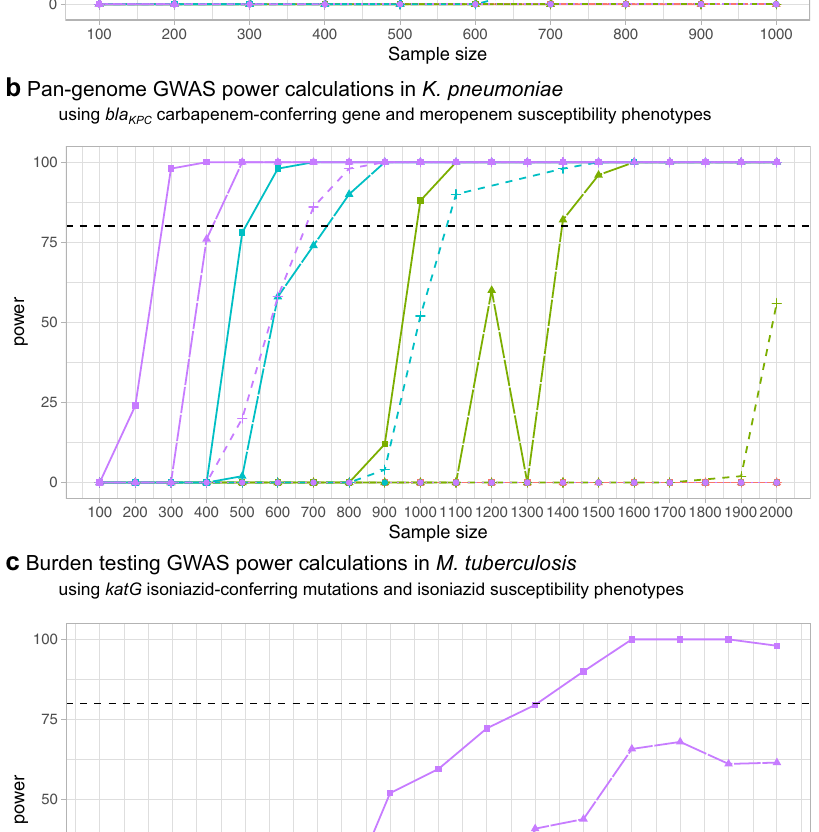
were needed to detect moderate (OR = 5) to very large (OR = 100) effect sizes of genes of 10% frequency, regardless of the bacterial population considered (Table 2); and 200 – 500 or less to detect genes of 25% frequency. Larger sample sizes of at least 2000 – 2500 genomes are needed to detect genes of 2.5% fre- quency. In addition, we tested the effect of increasing heritability and found that, as expected, the higher the heritability of